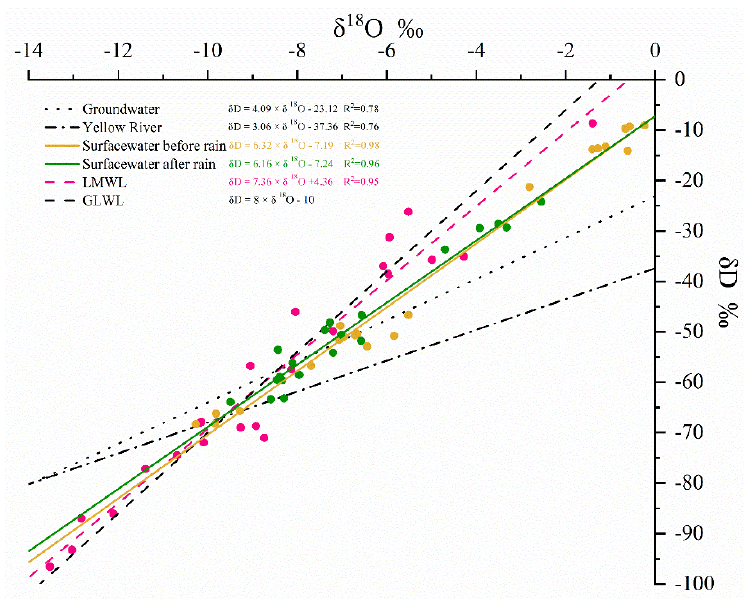
Figure 3. The lines of fit distributions between δ D-H 2 O and δ 18 O-H 2 O in the study area. The ISOsource model was established based on δ D- 18 O dual-isotope and the source and contribution ratios of surface water analyzed (Figure 4a). Before the rains, surface water was mainly recharged by groundwater (39.0%) and the Yellow River (33.6%). The proportions of precipitation (2.3%) and seawater (25.2%) recharge were relatively low. The water sources of different rivers were quite different. Water replenishment in the study area after the rains was dominated by water from the Yellow River (52.5%) and precipitation (28.8%), and the average seawater replenishment ratio was 6.8%. Guangli River had the highest proportion of water from the Yellow River (73.7%), and precipitation was the main water source for the Zhimai River (68.5%).